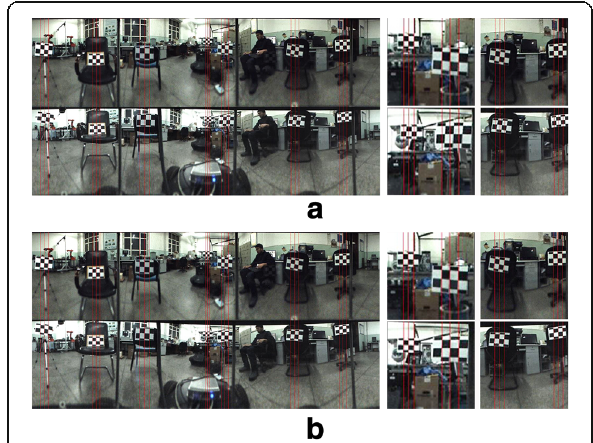
Fig. 11 Cylindrical expansion results and details. a On the left are obtained after cylindrical expansion using intrinsic parameters but without our rectification method, and on the right ( a ) are details of the left ( a ). b On the left are obtained after cylindrical expansion using intrinsic parameters and our rectification method, and on the right ( b ) are details of the left ( b ) with our rectification